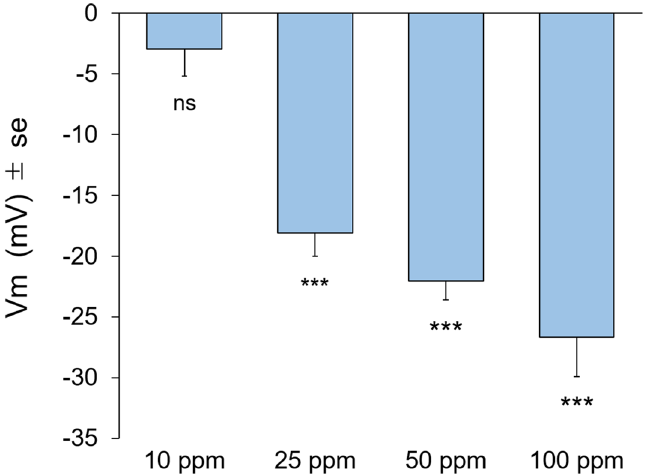
Figure 4. Membrane potential (Vm) depolarisation of plants after perfusion of leaf segments with ( Z )-11- 16:Ald. Leaves were perfused for 1 h with a solution containing MES buffer + 0.1% Tween 20 and different concentrations of ( Z )-11-16:Ald. Vm depolarisation indicates the difference in membrane potential between the mean values of each treatment with the control being a solution of MES buffer + 0.1% Tween 20. Perfusion with the ( Z )-11-16:Ald induced a Vm depolarisation of Brassica nigra cells. Error bars indicate SE. *** P < 0.001. ns indicates non-significant differences. n = 3 to 4 for each treatment.